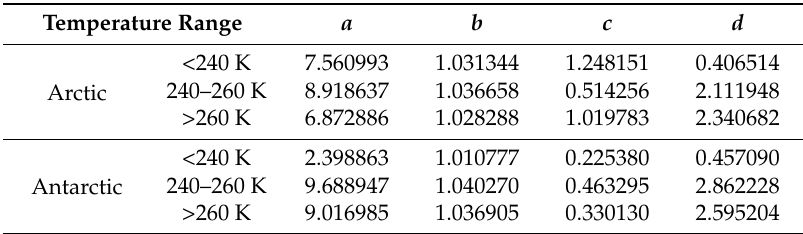
Table 2. Values of coefficients in Equation (1) for Suomi National Polar Orbiting Partnership (S-NPP)